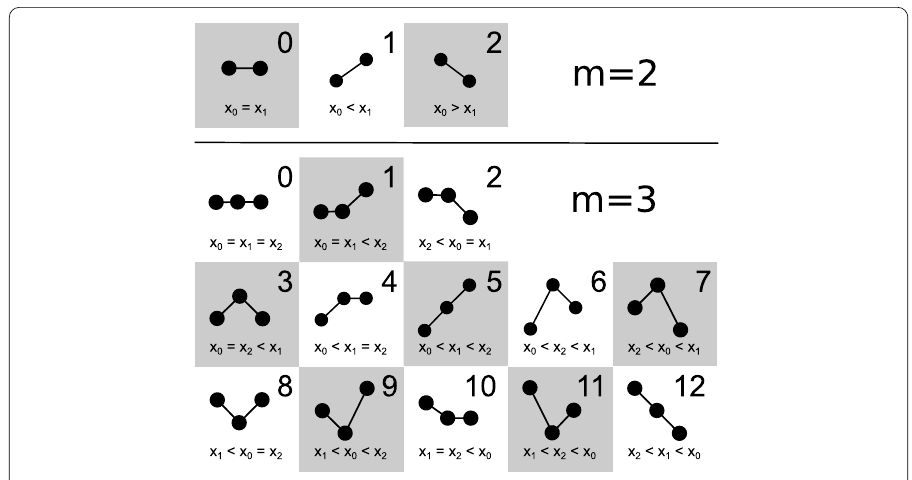
Figure 2 Symbolization. All possible symbols for m = 2 and m = 3 considering that identical values might appear in the original series